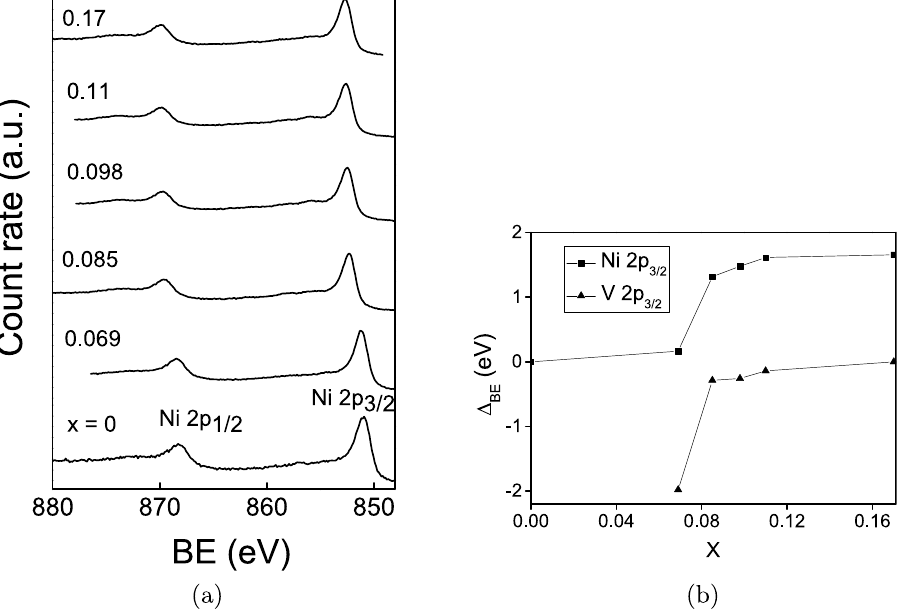
Figure 4. ( a ) High-resolution XPS spectra in Ni 2p region. ( b ) Variation of Ni and V peak positions with x .